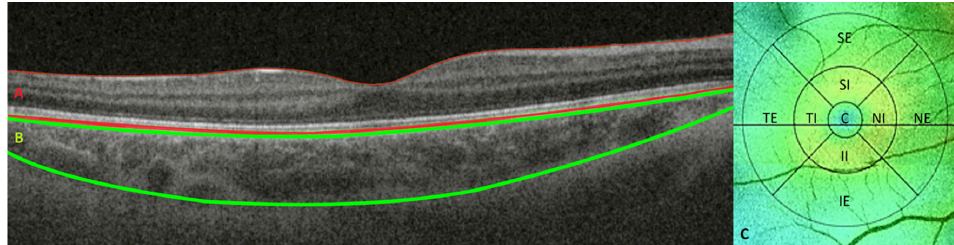
Figure 1. Total retinal thickness is between the red lines ( A ), choroidal thickness is between the green lines ( B ), and the nine areas of the ETDRS grid ( C ) measured by deep range imaging (DRI) Triton swept source (SS)-OCT for a right eye. (Abbreviations C, Central; SE, Superior External; TE, Temporal External; NE, Nasal External; IE, Inferior External; SI, Superior Internal; TI, Temporal Internal; NI, Nasal Internal; II, Inferior Internal).